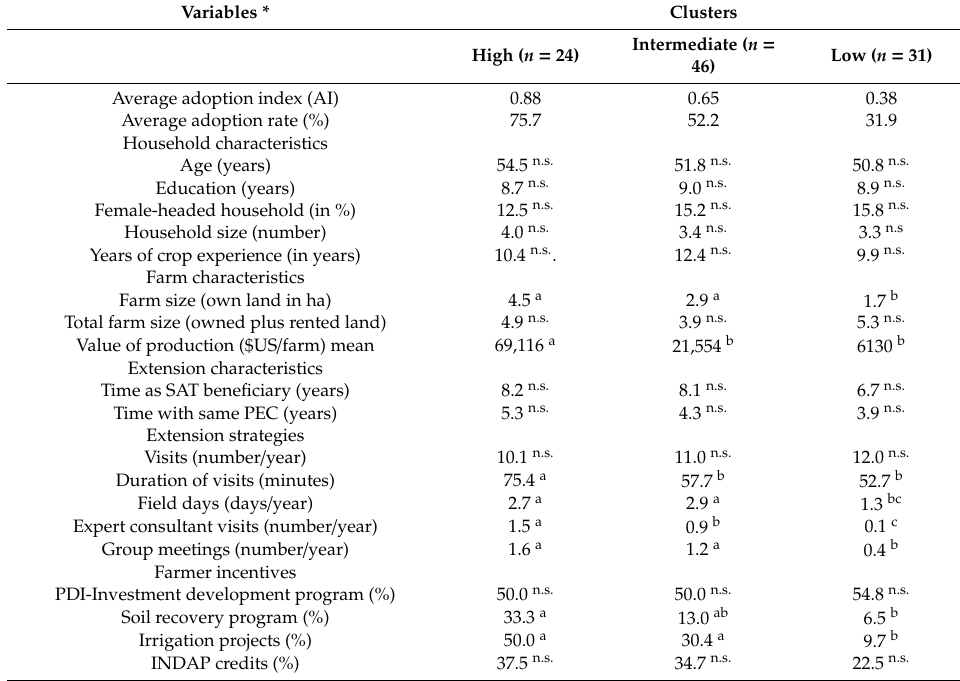
Table 3. Farmer and extension characteristics for three